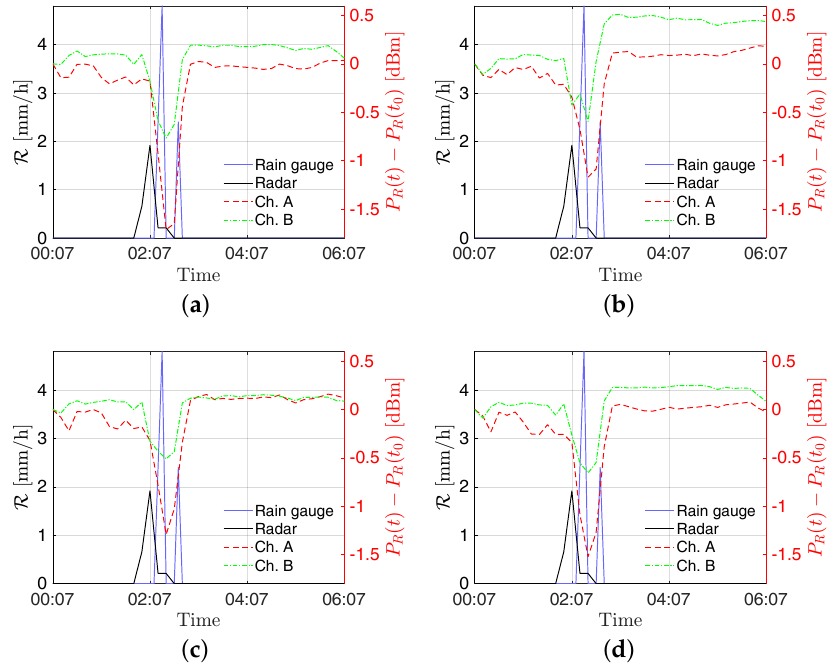
Figure 7. Received power variation [ dBm ] at the sites ( a ) S2 − Torcia, ( b ) PZS1, ( c ) Pala Eolica, and ( d ) Uffici Ingr on 4 July 2018. The signal power variations for channels A and B refer to the right y -axis, whereas the rain intensities R provided by the radar and the RG refer to the left y